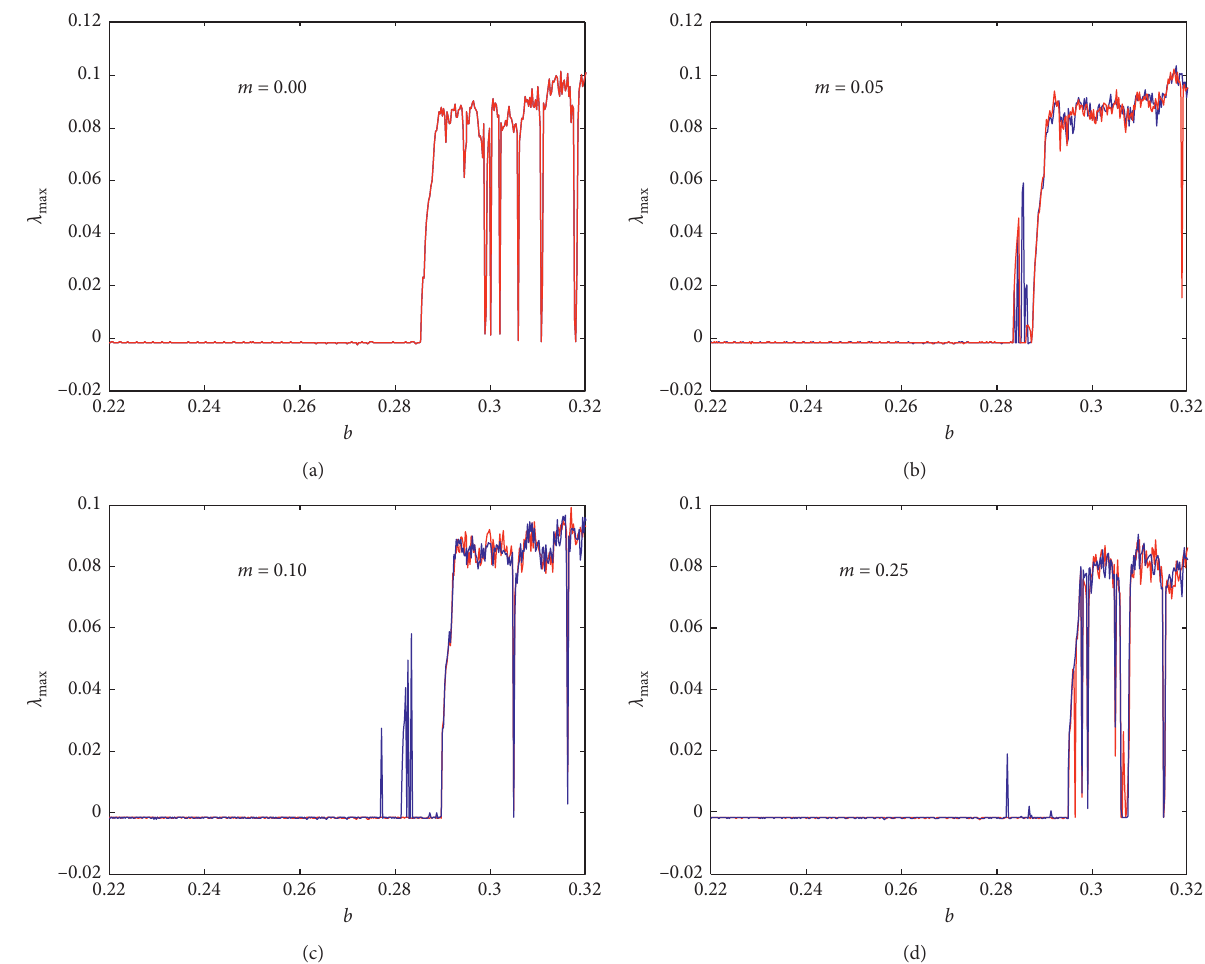
Figure 2: Diagrams of the maximum Lyapunov exponents, corresponding to the bifurcation diagrams of Figure 1. This figure shows the impact of the value of m on the symmetry of system (2) considering b as a control